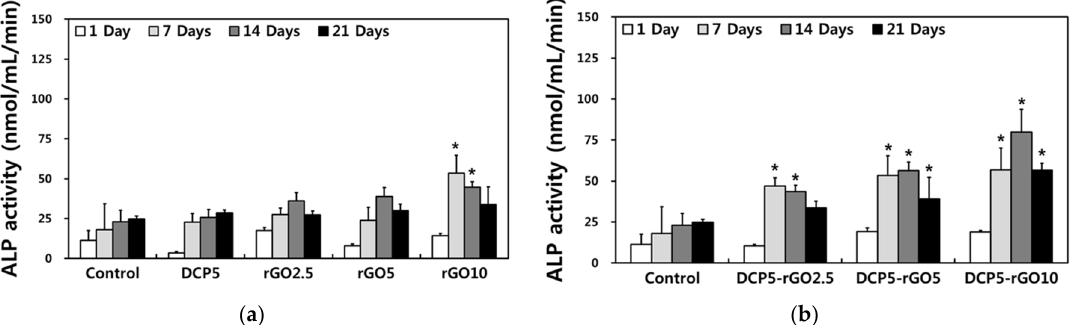
Figure 5. ( a ) ALP activity of MC3T3 ‐ E1 cells treated with 5 μ g/mL of DCP or 2.5, 5, and 10 μ g/mL of rGO. ( b ) ALP activity of MC3T3 ‐ E1 cells treated with DCP ‐ rGO hybrid composite. Cultures with fresh media were used as the negative control. An asterisk (*) denotes a significant difference compared with the control, p < 0.05.